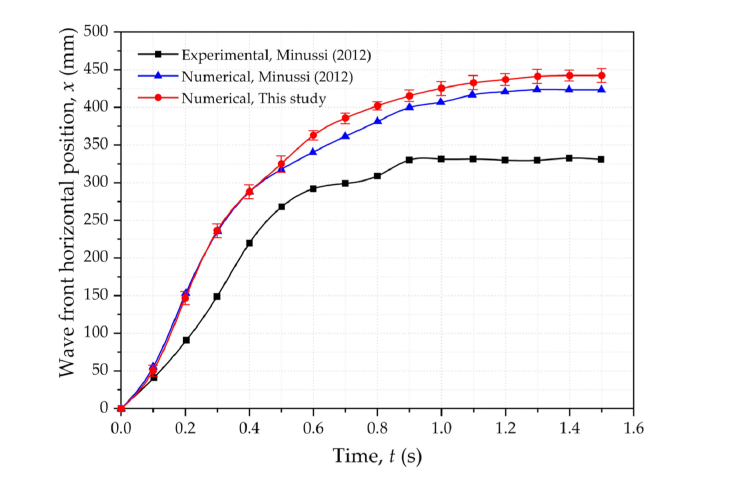
Figure 2. Numerical–experimental comparison of the wave front horizontal positions.